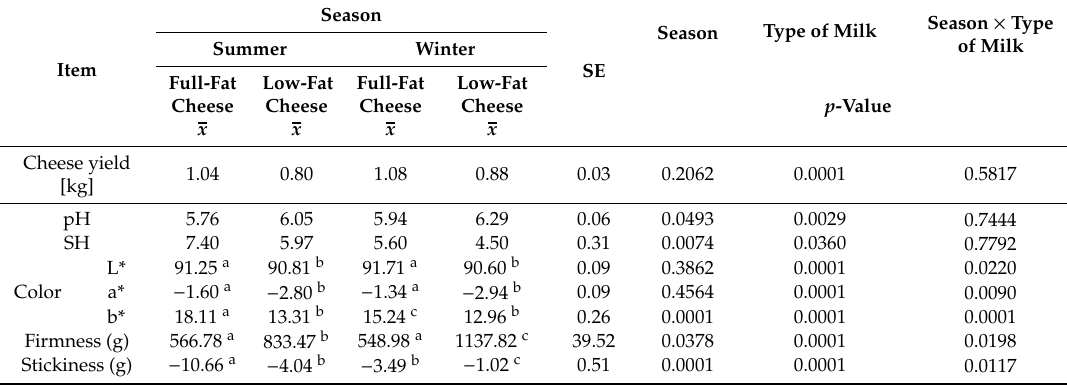
Table 3. Physicochemical and rheological analysis of the cheeses depending on the season and the type of